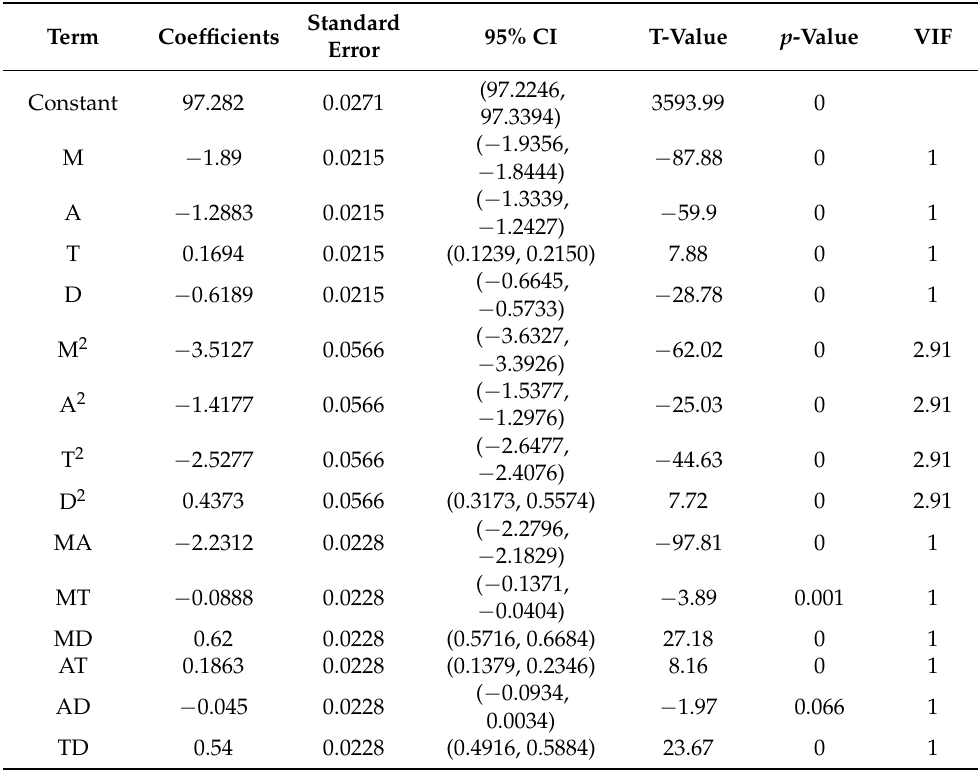
Table 11. Coefficients of the coded parameters and the VIF of the response model for the esterification process of WCO.